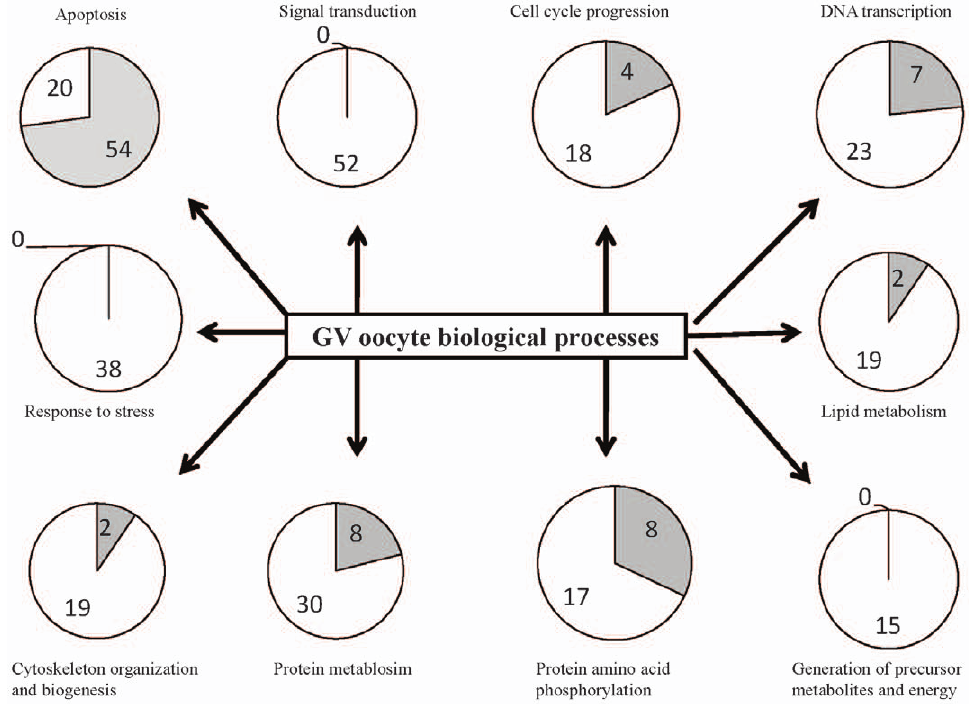
Figure 5. Germinal vesicle (GV) oocyte biological processes. Numbers of proteins agonistic (white) or antagonistic (grey) for each biological process including signal transduction, cell cycle regulation, DNA transcription, apoptosis regulation, protein metabolism and modification, generation of precursor metabolites and energy, cytoskeleton organization and biogenesis, and response to stress and calculated the net effect.